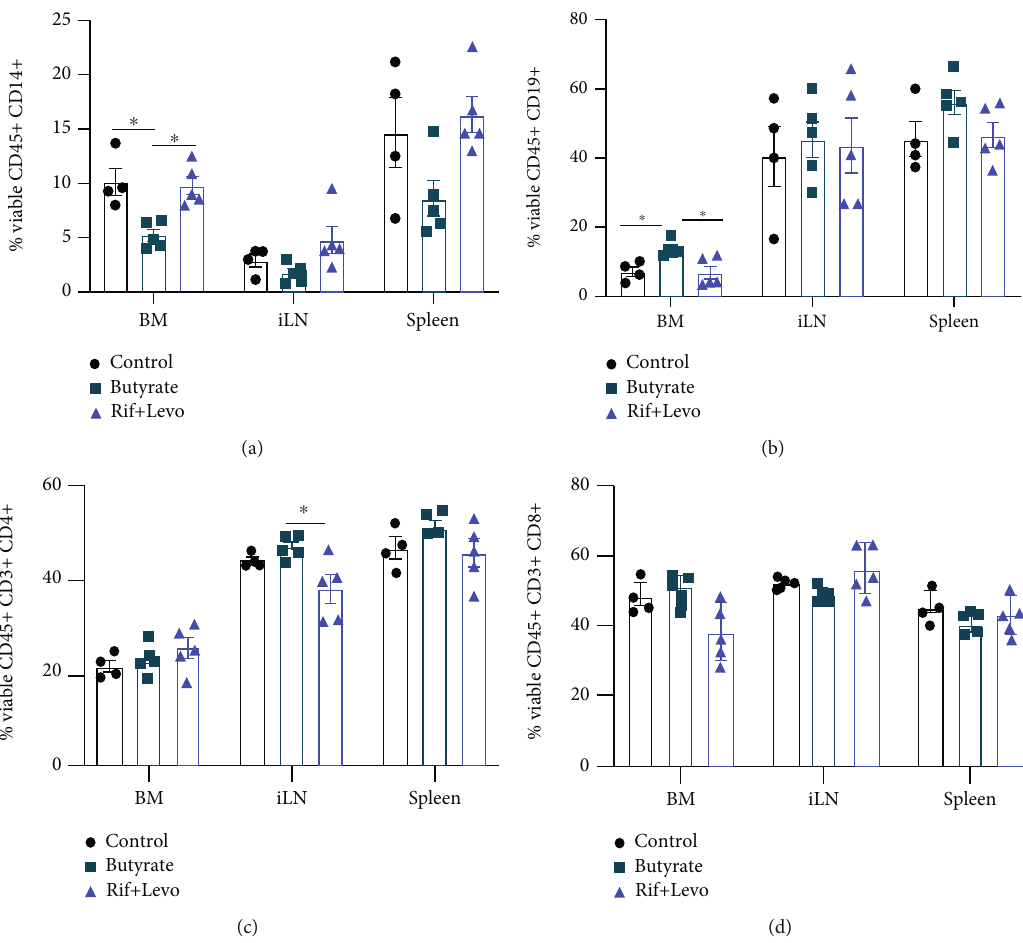
Figure 5: Butyrate treatment decreases the CD14+ monocyte/macrophage population but increases the CD19+ B cell population in bone marrow following osteotomy. Immunophenotyping of single-cell suspensions from bone marrow (BM), inguinal lymph node (iLN), and spleen from operated mice was performed. (a) Percent of viable CD45+ CD14+ monocytes/macrophages, (b) CD45+ CD19+ B cells, (c) CD45+ CD3+ CD4+ T cells, and (d) CD45+ CD3+ CD8+ T cells in spleen, iLN, and BM, in the absence and presence of butyrate and Rif + Levo , respectively. Data shown are means ð n = 4 ‐ 5 Þ ± SEM . ∗ p < 0 : 05